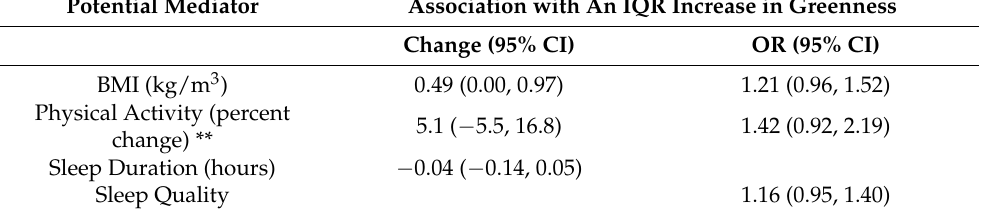
Table 3. Associations between greenness measured at the 250 m buffer size, and potential mediators for the association with fasting glucose. Results presented from models where each mediator was modelled as the outcome of interest, both as continuous and binary* variables in linear and logistic models,